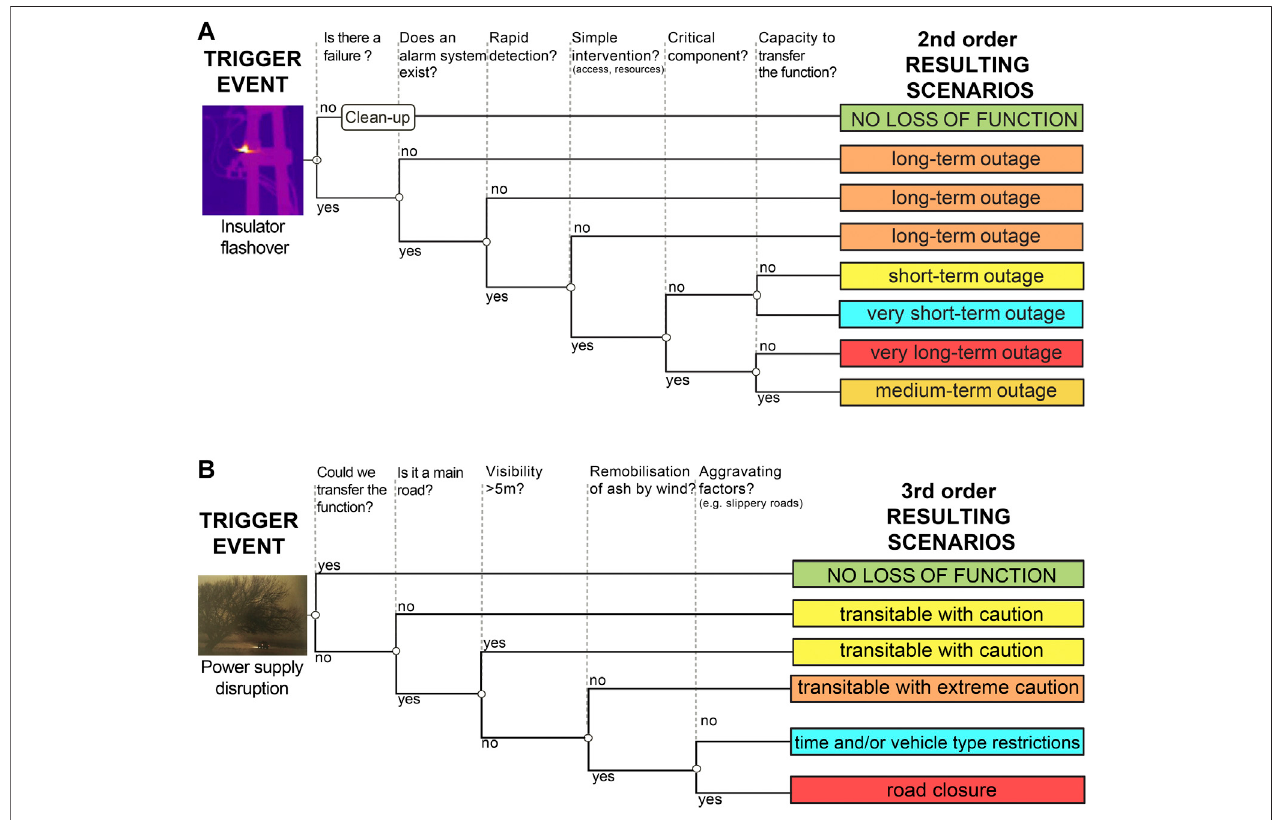
FIGURE9|(A) Secondorderofimpact:lossoffunctionalityofthepowersystemduetothe fl ashoverofinsulatorsdescribedbyaneventtree.Colorscalefromblue toredindicatesthedurationoflossoffunctionalityfromvery-shorttermtovery-longtermoutage. (B) Thirdorderofimpact:lossoffunctionalityoftheroadsystemdueto thepowersupplydisruptiondescribedbyaneventtree.Colorscalefrombluetoredindicatestheconsequencesofimpactintermsofdegreeofcautionorrestrictionson the road network. Photo courtesy: Cooperative of Electricity of Bariloche (insulator fl ashover) and Chino Leiva (power supply disruption).